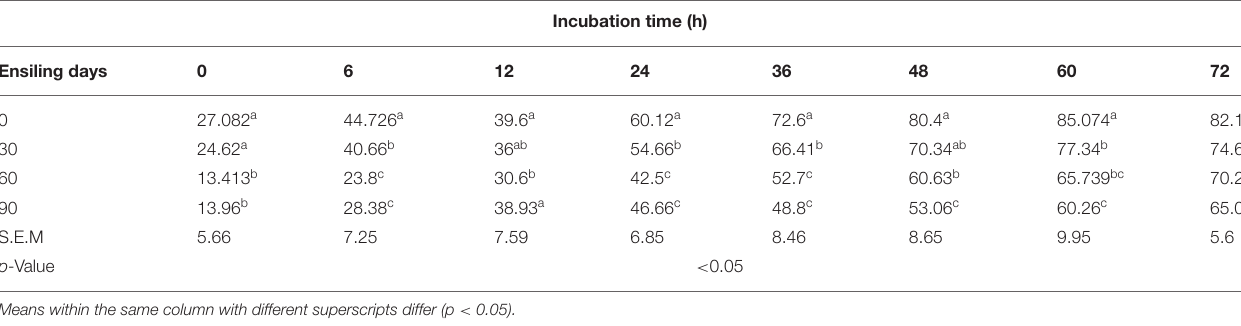
TABLE 7 | Effect of the ensiling duration on average DM degradability of forage rape silage after 0, 6, 12, 24, 36, 48, 60, and 72h incubation in situ technique. Incubation time (h)